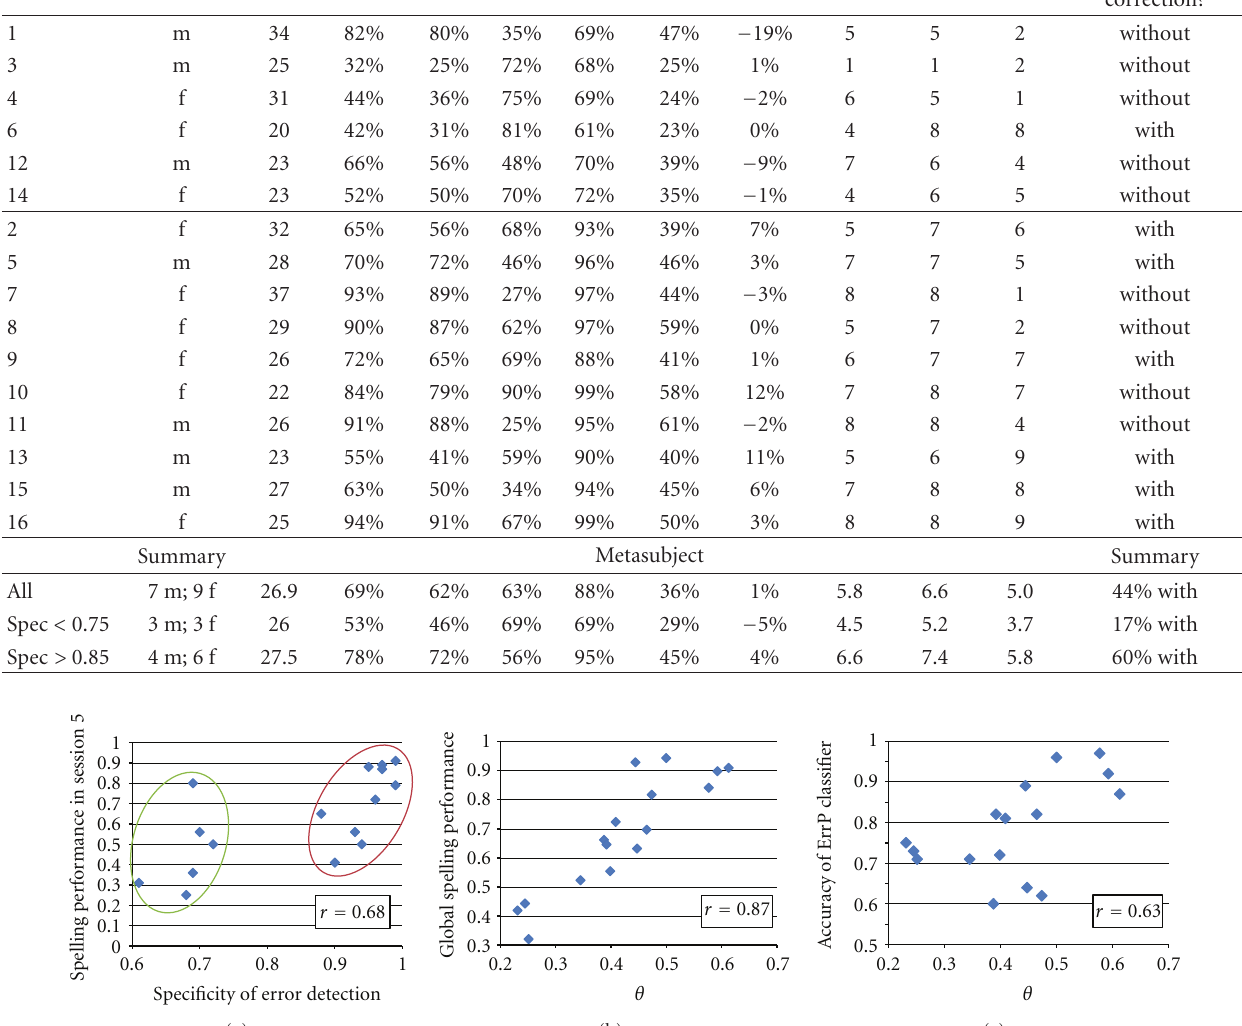
Table 1: Individual and group performance in spelling, error detection, and correction. The first three columns indicate the subject number and demographical information such as gender and age. The next two columns indicate the spelling accuracy (percent of correct letters) for the whole five sessions (mixing words spelled with 2 and 4 sequences) and for the fifth session alone (the one dedicated to online evaluation of error correction, without considering the online correction), respectively. The next four columns indicate the individual sensitivity, specificity, θ , and gain in spelling accuracy obtained in the last session, reported in percent. The last four columns show the individual responses to the most relevant questions (see Table 2 for a full description). The last three lines provide results at the group level (first line) and after having distinguished between low specificity (second line) and high specificity (third line) performers. Dem. info. Subjects